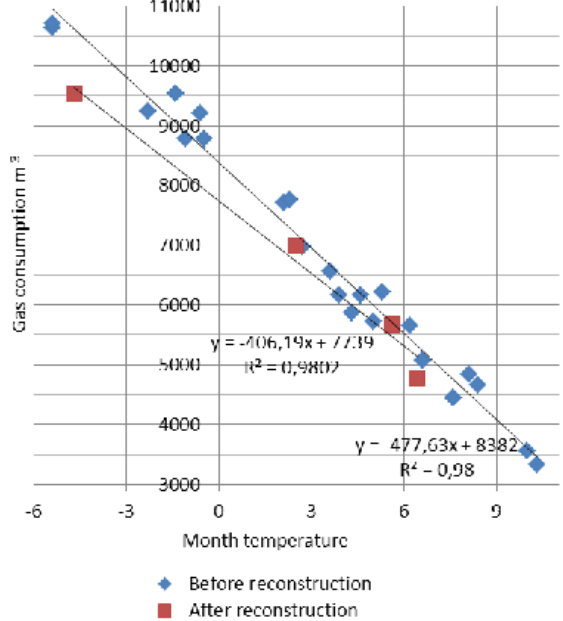
Fig.7. Gas consumption data for 30 and 31 days